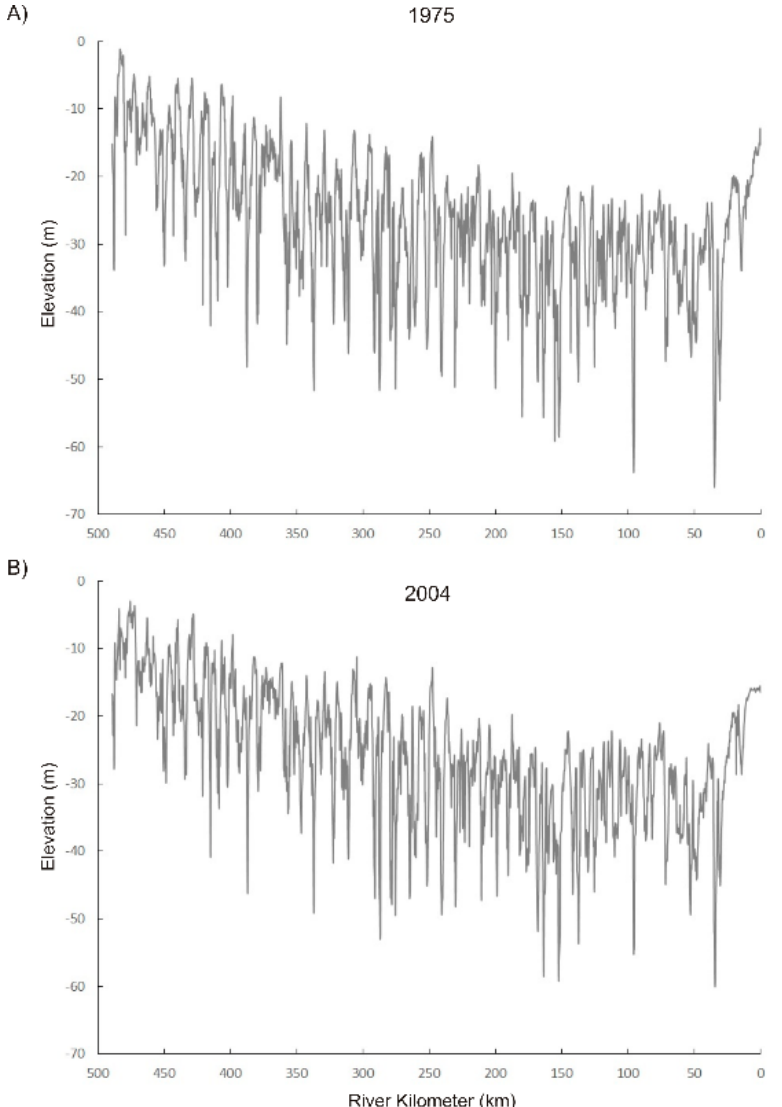
Figure 6. Two other thalweg profiles in 1975 ( A ) and 2004 ( B ) are only used for comparing the cumulative elevation changes of thalweg in different times without identified riffles or pools. The elevation values are above NAVD 88.